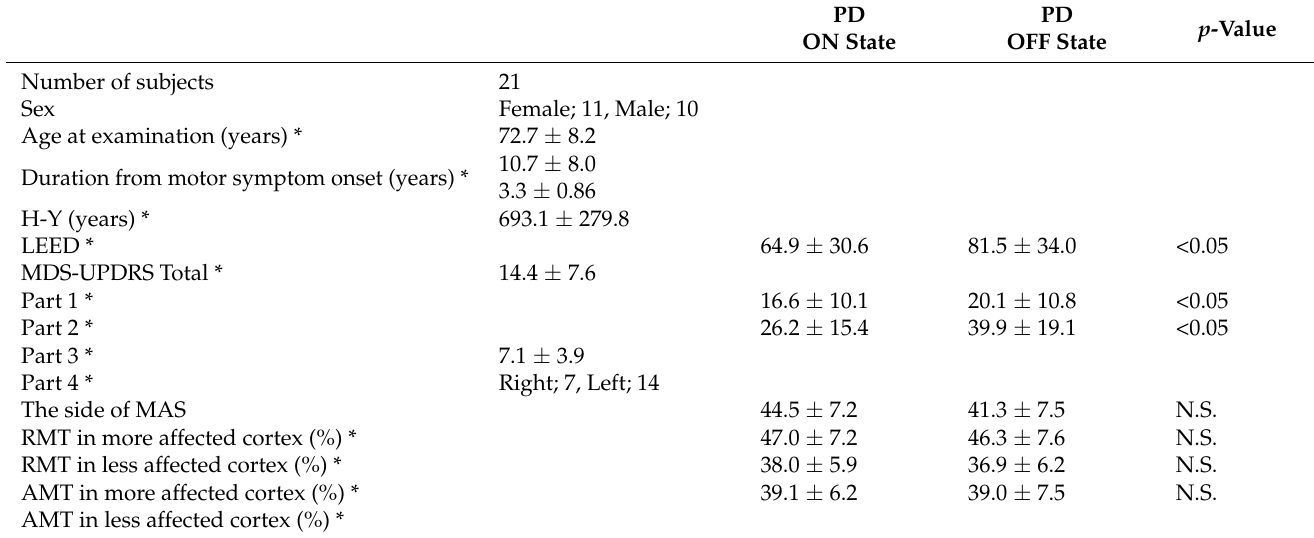
Table 1. Clinical features of patients with PD ( n =